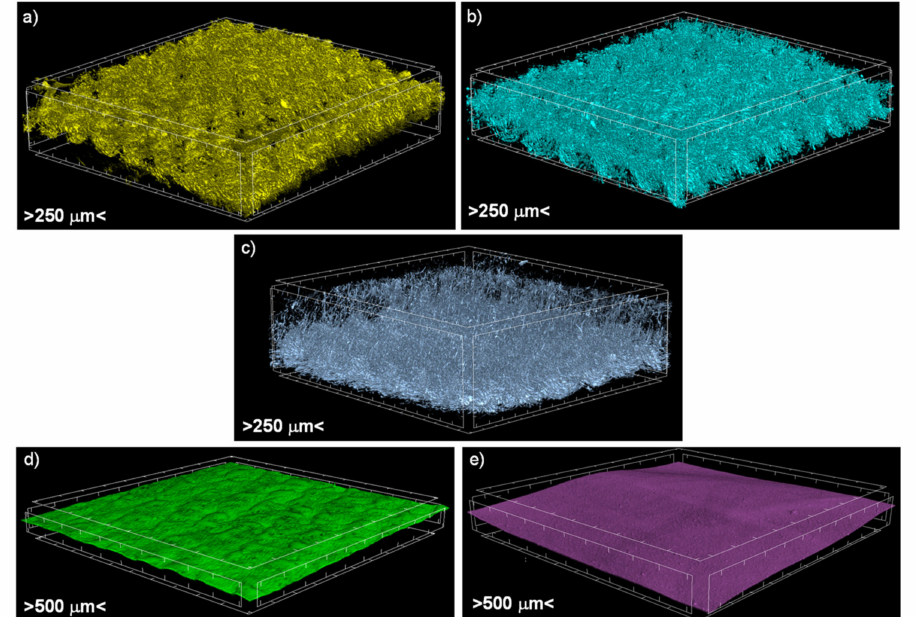
Figure 2. Micro-CT images of ( a ) knitted fabric made of Cotton LM, ( b ) knitted fabric made of Cotton HM, ( c ) brushed knitted fabric made of PES, ( d ) vapor permeable membrane made of PU, ( e ) vapor permeable membrane made of PP.